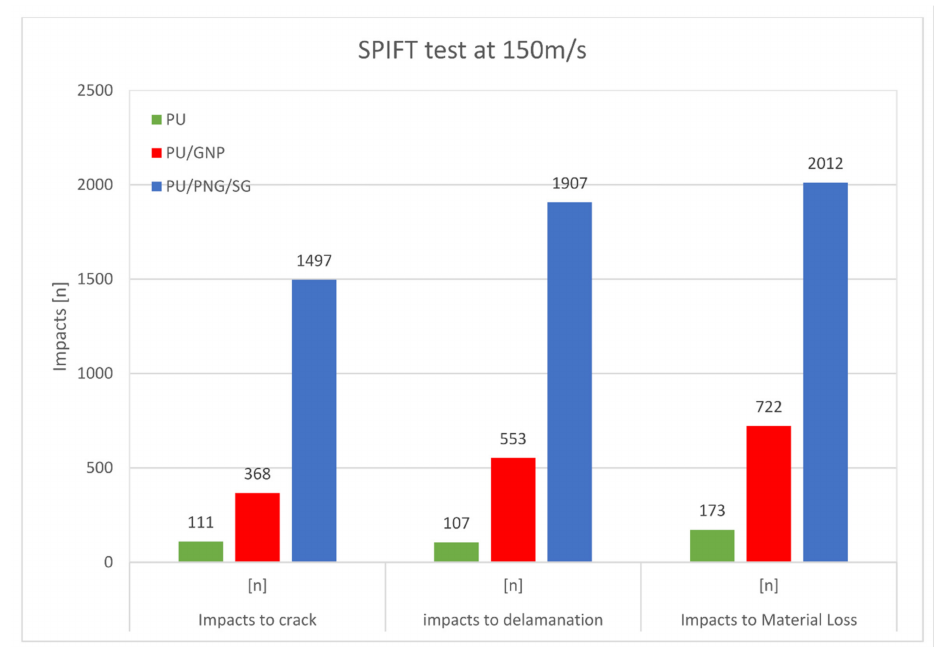
Figure 8. Impacts to failure at 150 m/s for PU, PU + GNP, PU + GNP + SG. Each color represents a single test.